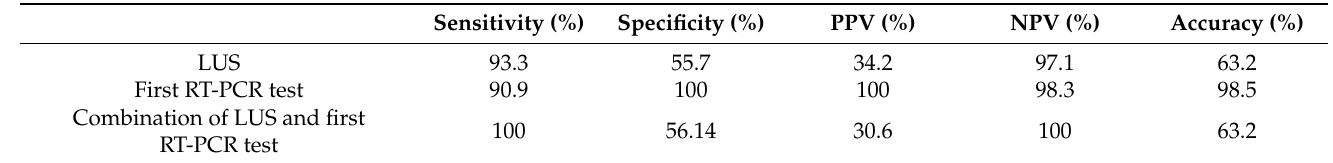
Table 2. Diagnostic significance of LUS score classification, first RT-PCR test, and in combination of both in COVID-19 suspected patients.